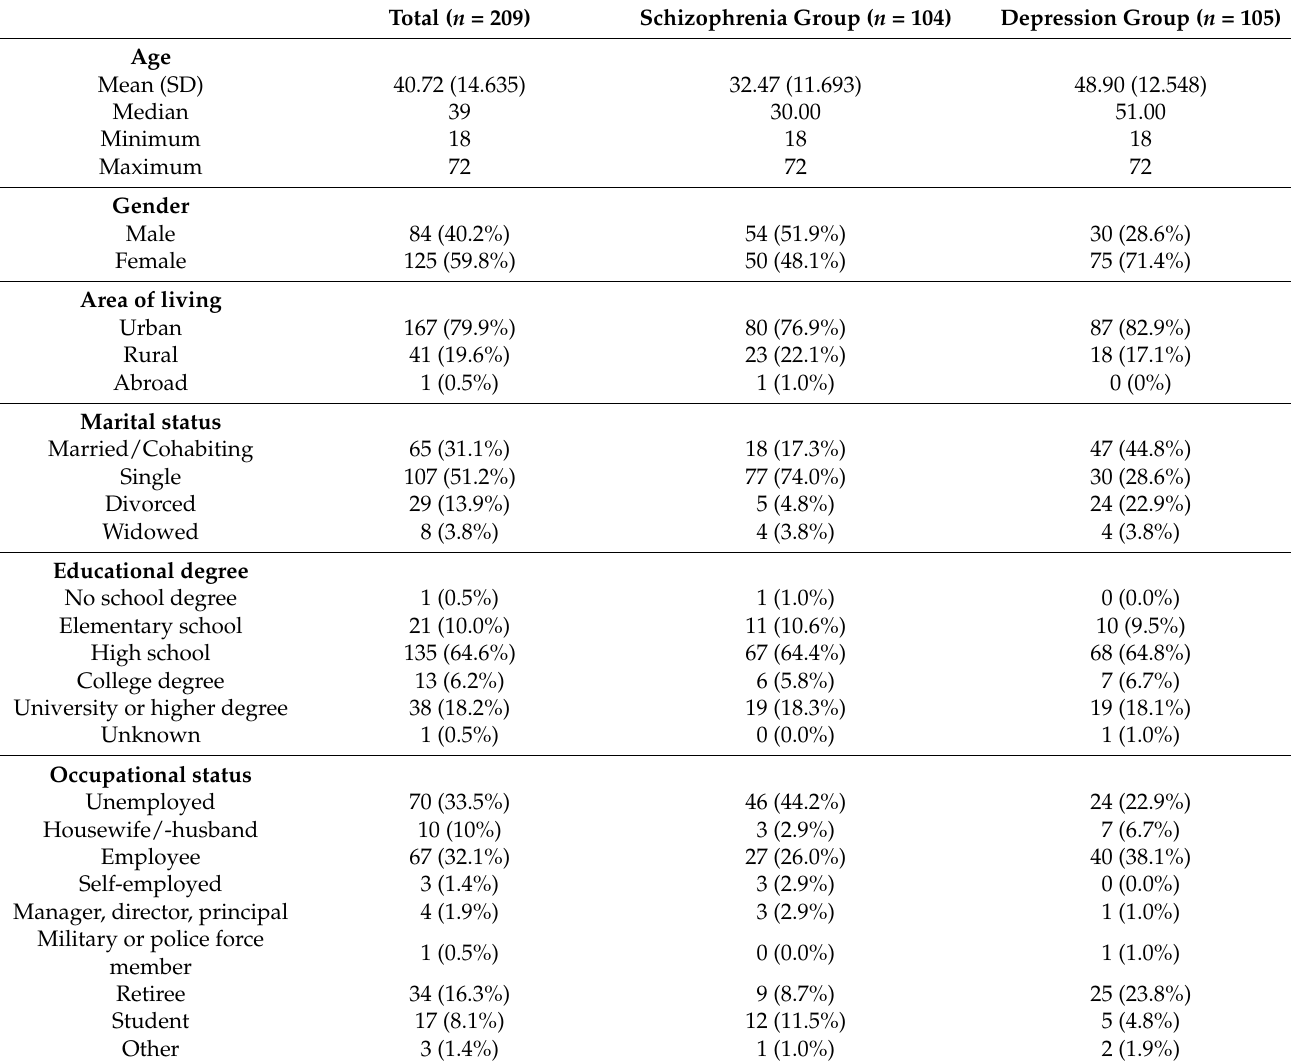
Table 1. Sociodemographic characteristics of the sample.